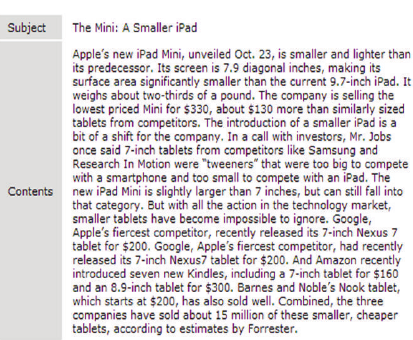
Figure 10: Resource of a test object.